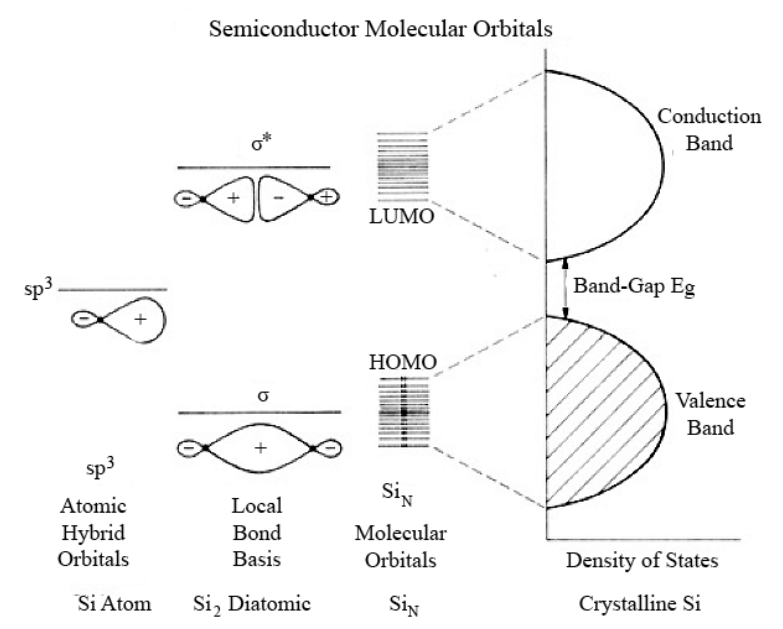
Figure 8. Combination of atomic orbital to molecular orbital and to band-gap of silicon molecule (Reprinted with permission from [107]. Copyright 1990 American Chemical